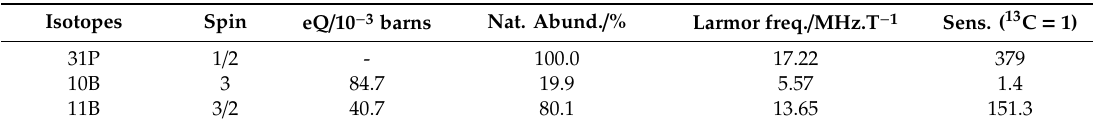
Table 1. Nuclear properties of 31 P, 10 B, and 11 B isotopes. Quadrupolar moment (eQ), natural